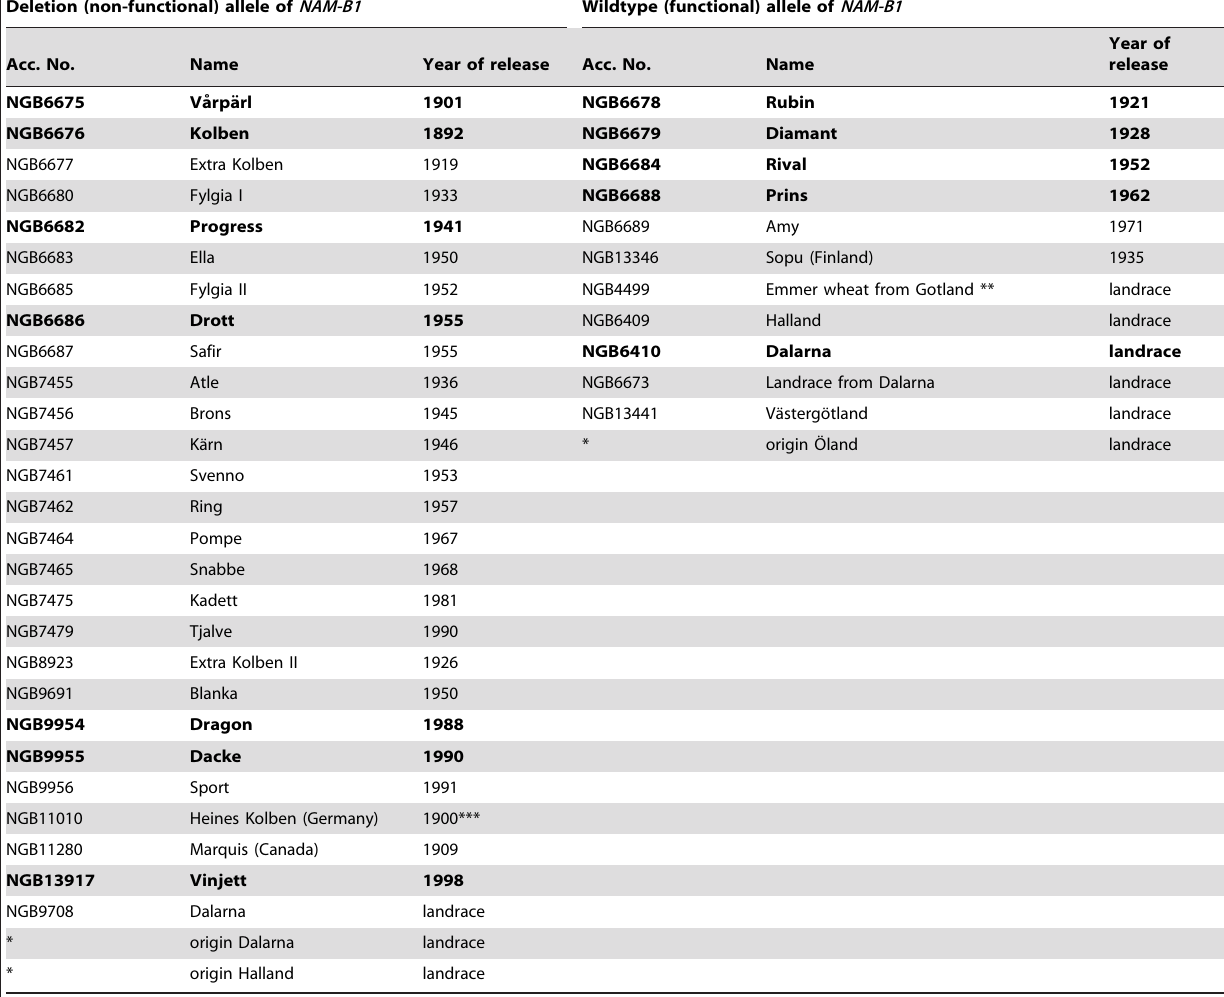
Table 1. Varieties used in the study, their allele types and year of release, with the subset of 12 varieties indicated in bold style.